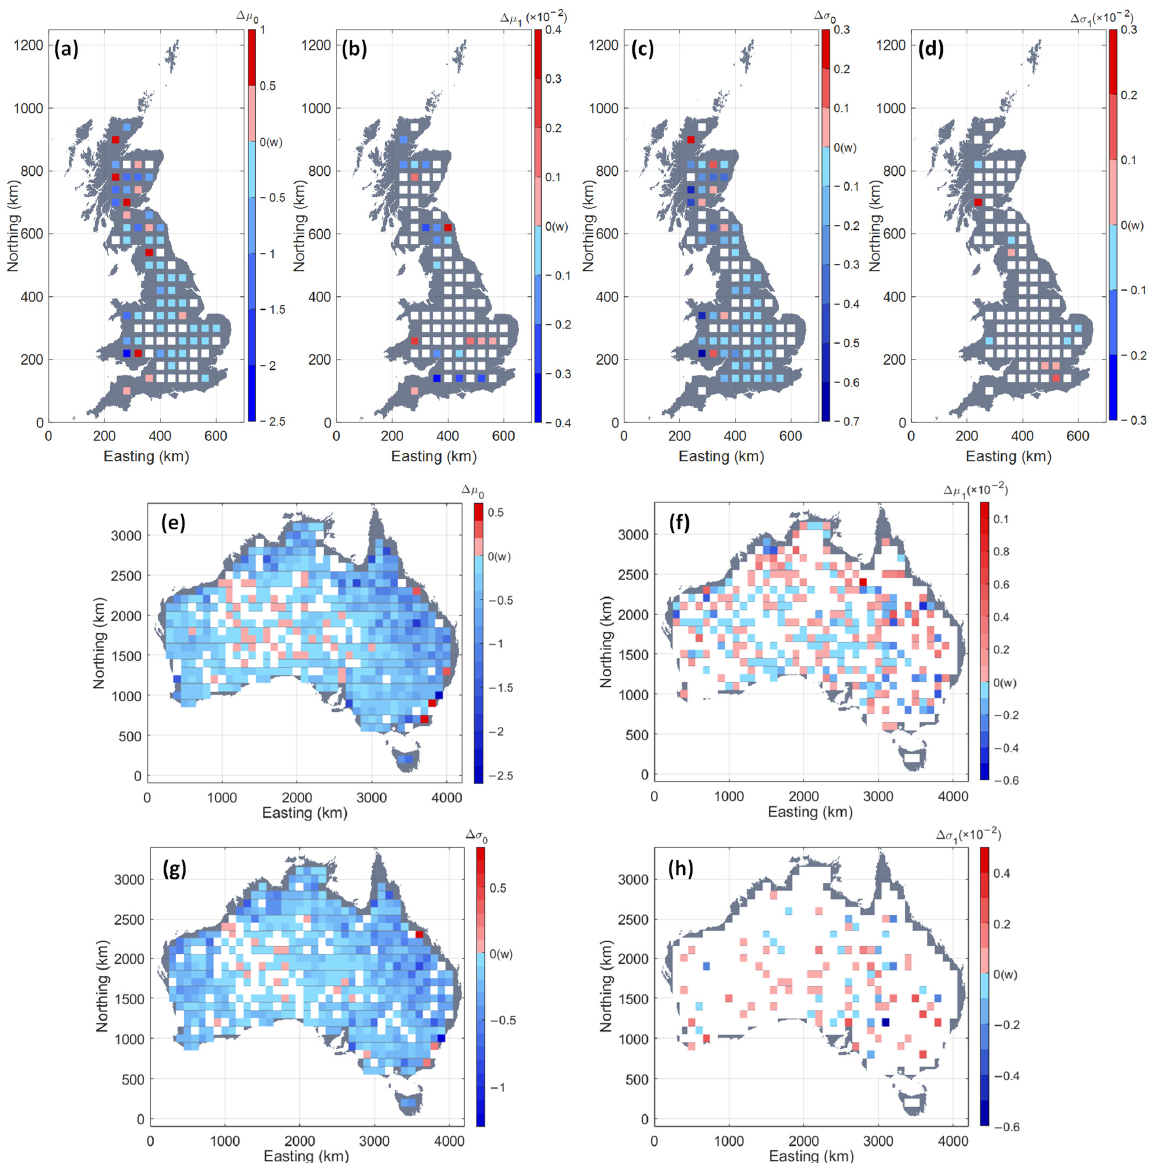
Figure 5. Spatial distribution of ROI groups whose parameters ( µ 0 , µ 1 , σ 0 , σ 1 ) change with the increase in ROI size in GB ( a – d ) and AU ( e – h ). Please noted that the white colour indicates the ROI with an insignificant change in the parameters. Noted that “w” shown in the colour bar indicates the colour white which means the changes of the parameter is zero.